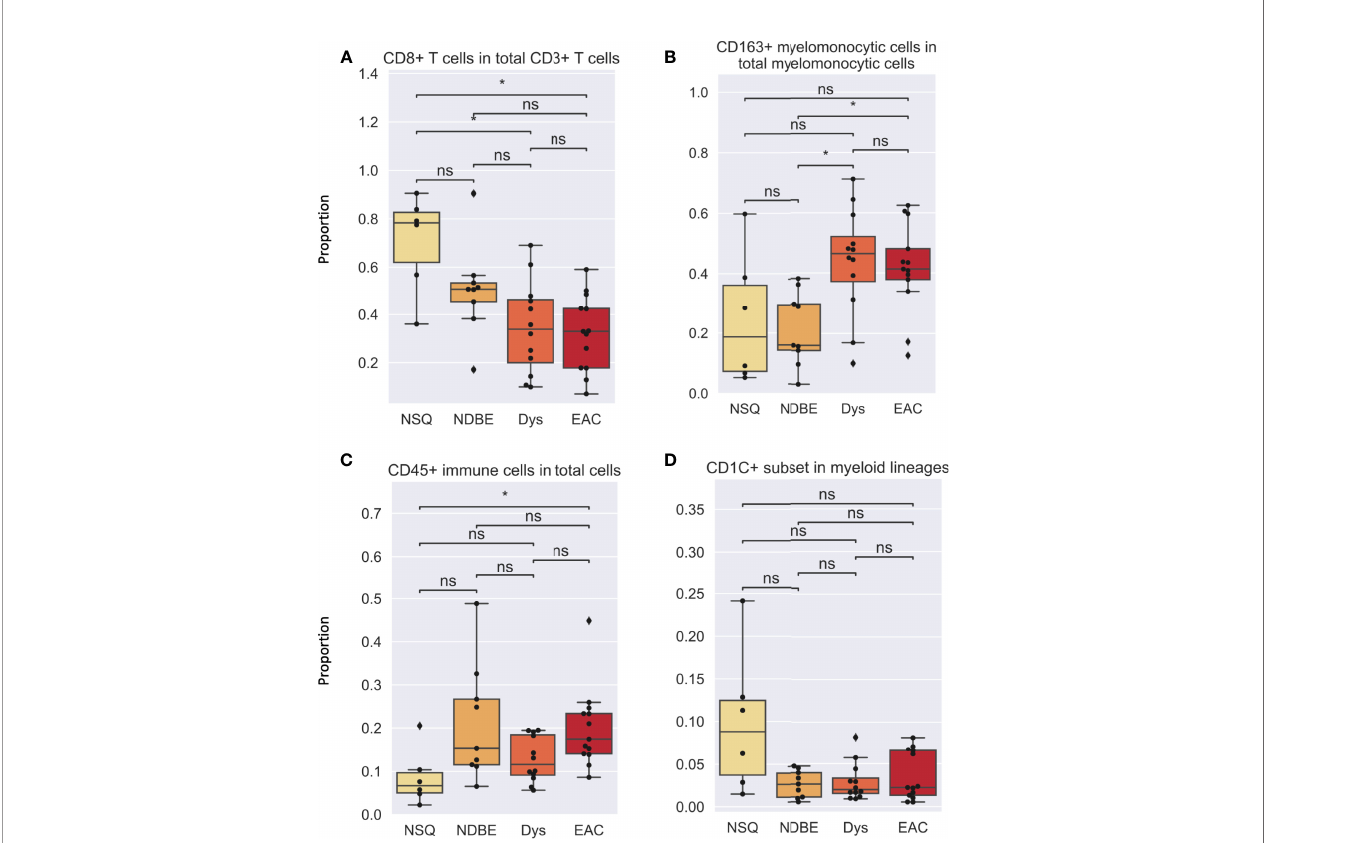
FIGURE 5 | Cell proportion of various gated cell subsets based on Image Cytometry at different disease stage. (A) CD8 + T cells in total CD3 + T cells, (B) CD163 + myelomonocytic cells in total myelomonocytic cells, (C) CD45 + immune cells in total cells, (D) CD1C + subset in myeloid lineages. Each datapoint represent one ROI. Statistics: Mann-Whitney-Wilcoxon test two-sided with Bonferroni correction: ns (not signi fi cant): p > 0.05; *p ≤